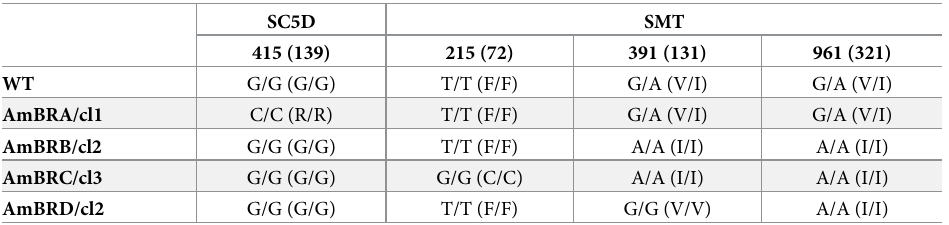
AmBRA/cl1 AmBRB/cl2 AmBRC/cl3 G/G (G/G) AmBRD/cl2 G/G (G/G) T/T (F/F) A/A (I/I) Where variants were detected in sterol biosynthesis genes, genotypes at these loci are shown, along with the coded amino acids in brackets. SMT genotypes combine both SMT copies, LmxM . 36 . 2380 and LmxM . 36 . 2390 , due to the difficulty of discriminating between these gene copies by